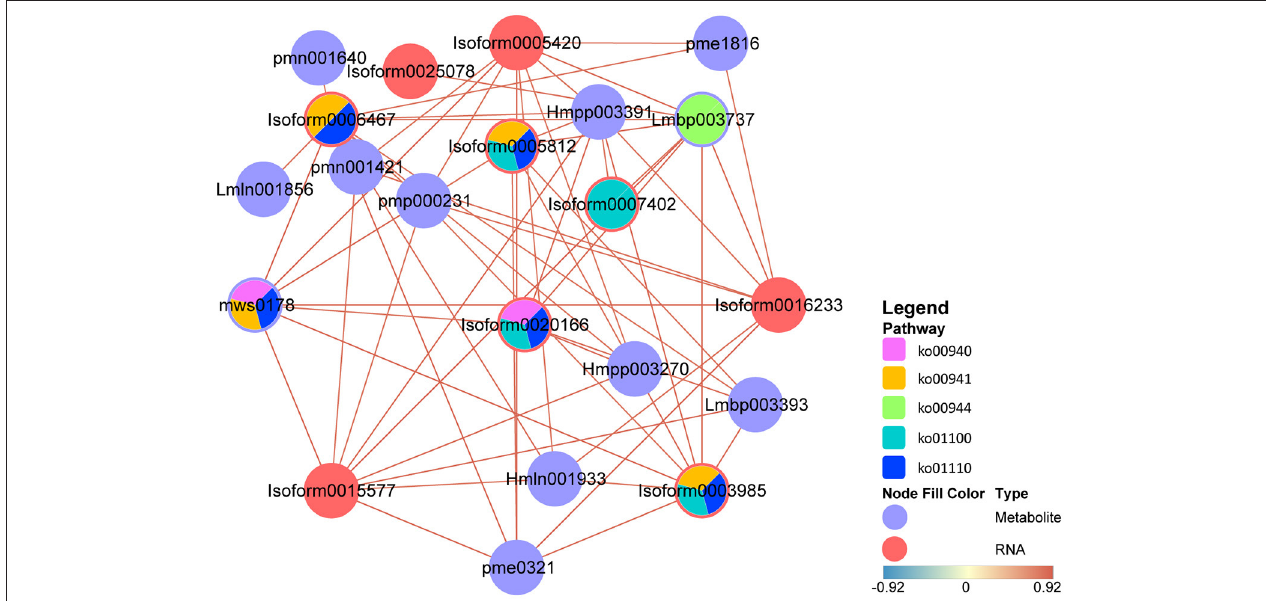
FIGURE 7 | Transcript-metabolite Pearson’s correlation network representing DAMs and DEGs involved in M. pasquieri . The gene-metabolite pairs were connected within the network by edges. Red nodes represent genes, and purple nodes represent metabolites. The edges between nodes represent correlation. The color bar below indicates red edges represent positive correlations, and blue edges represent negative correlations. Only correlation pairs with a correlation coefficient > 0.8 were included in the network. The pie chart on the nodes shows part of pathways involved in DAM and DEG. DAMs, differentially accumulated metabolites; DEGs differentially expressed genes. Lmbp003393, quercetin-3-O- α -L-rhamnopyranoside; pme0321, kaempferol 7-O-rhamnoside; pmn001640, myricetin 3- α -L-arabinofuranoside; Lmbp003737, kaempferol-3-O-rhamnoside; Hmln001933, myricetin 3-O-galactoside; Hmpp003391, luteolin-3 ′ -O- β -D-glucoside; Hmpp003270, luteolin-4 ′ -O- β -D-glucoside; mws0178, chlorogenic acid; pmn001421, 3-O-(E)-p-Coumaroyl quinic acid; pmp000231, trans-3-O-p-coumaric quinic acid; pme1816, neochlorogenic acid; Lmln001856, 5,7-dihydroxy-4-oxo-2-(3,4,5-trihydroxyphenyl)-4H-chromen-3-yl- β